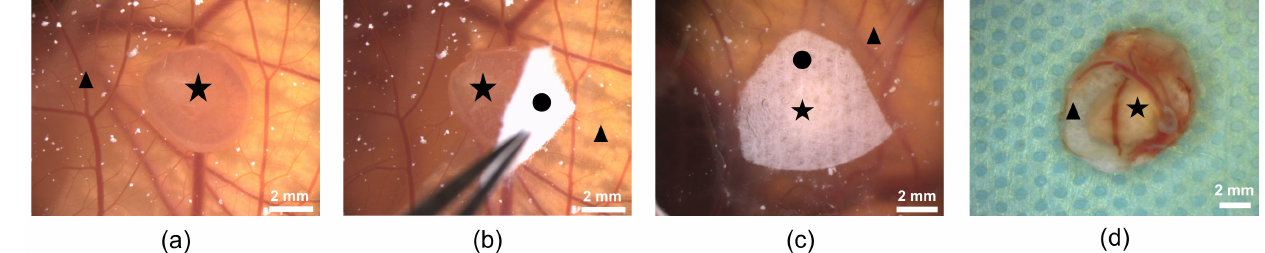
Figure 4. Mouse renal tissue on the CAM; ( a ) kidney slice after engraftment; ( b ) covering of the tissue with a piece of fleece; ( c ) kidney slice covered with fleece; and ( d ) kidney slice with surrounding CAM and distinct blood vessels after removal. ( (cid:78) : CAM with blood vessels; (cid:70) : kidney slice; • :